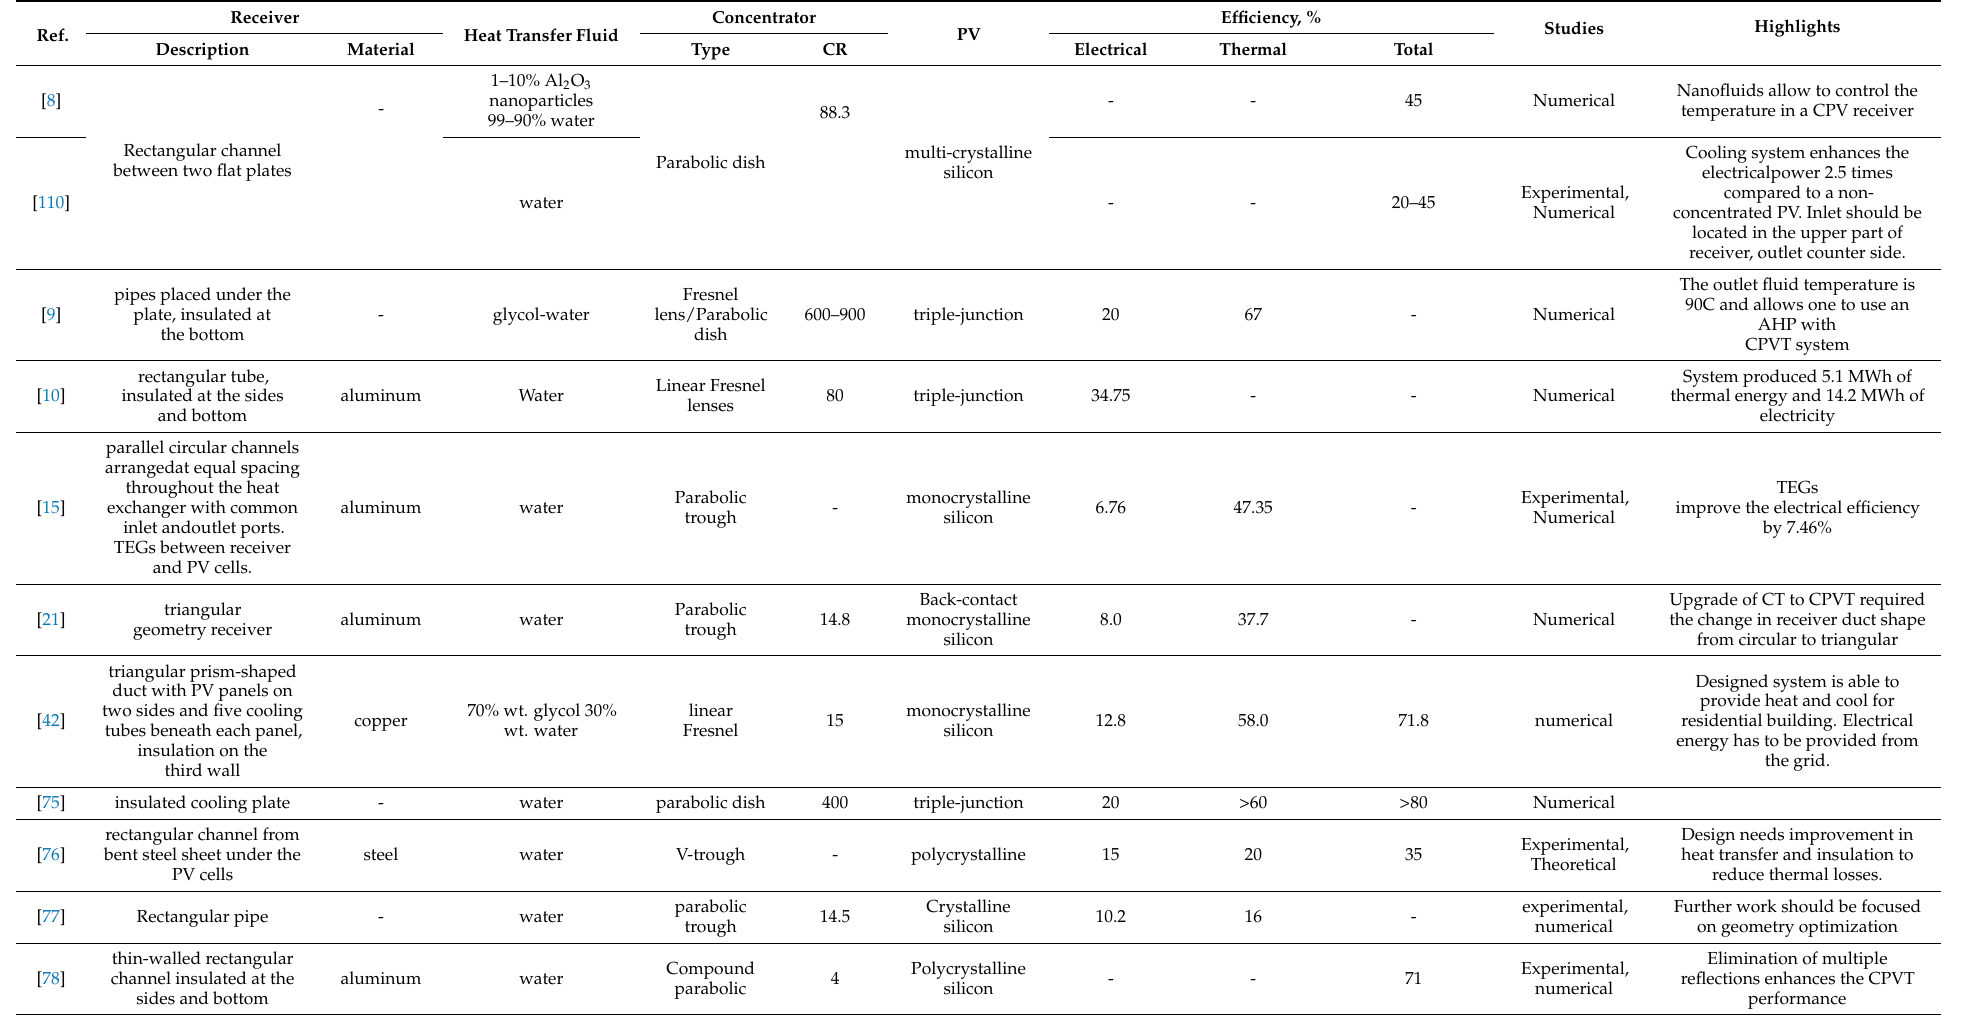
Table 4. Summary of discussed heat receivers with macro-scale